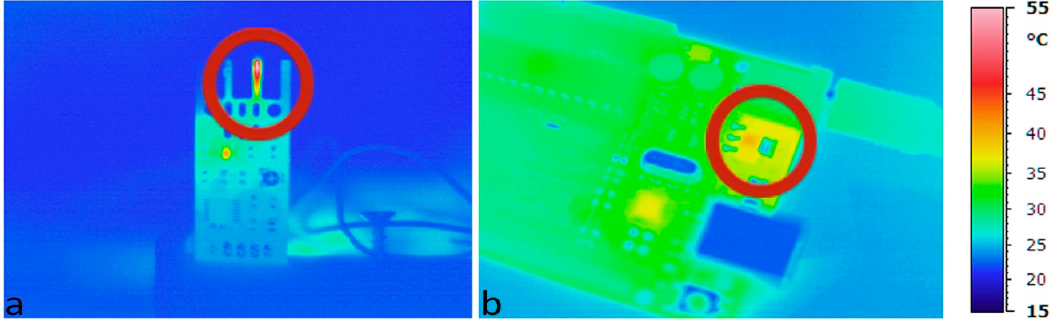
Figure 2. Thermal imaging: ( a ) anemometer; and ( b ) voltage regulator of the Arduino UNO. The system is powered by a 12 V (Vin) AC/DC adapter. The voltage regulator mounted on the Arduino UNO board provides an output voltage of 5 V (Vout). The current (I) through nEMoS is